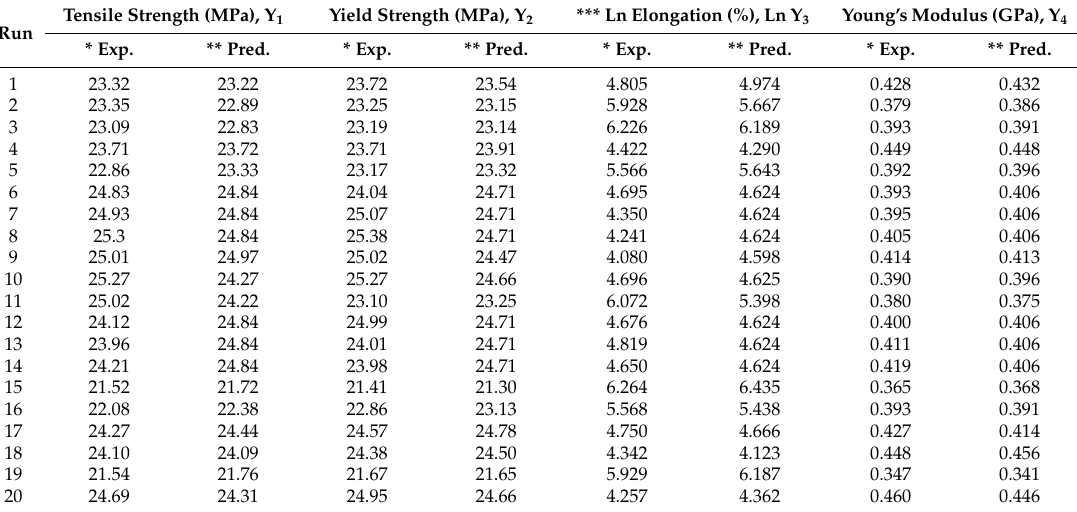
Table 1. The experimental and predicted values of